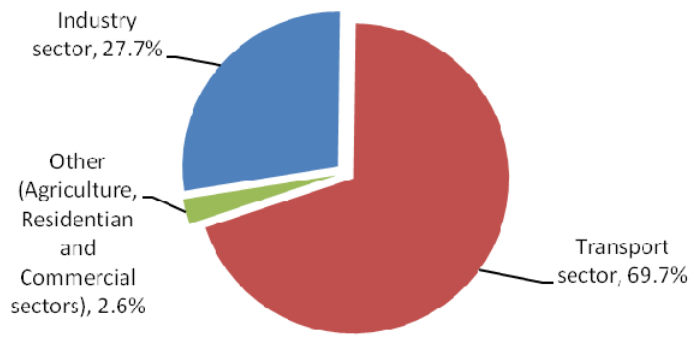
Figure 3. Share of transport, industry and other sectors for crude oil and petroleum product consumption (source: [1]).